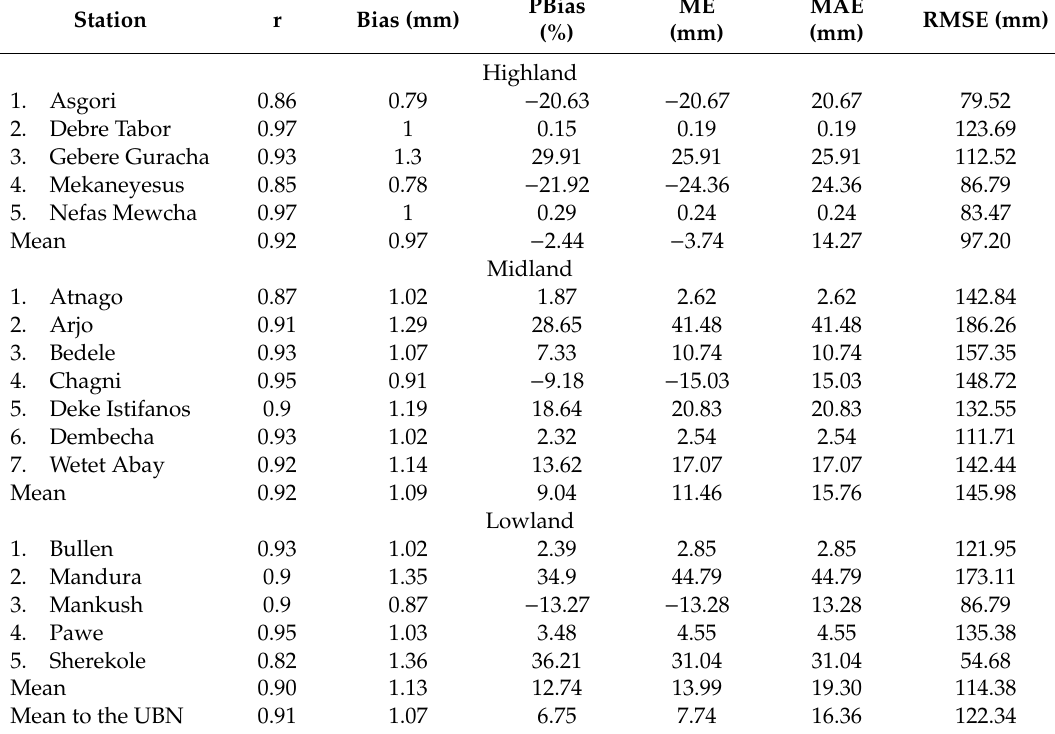
Table 3. Error report for CHIRPSv2 for the di ff erent elevation zones of the Upper Blue Nile. PBias: